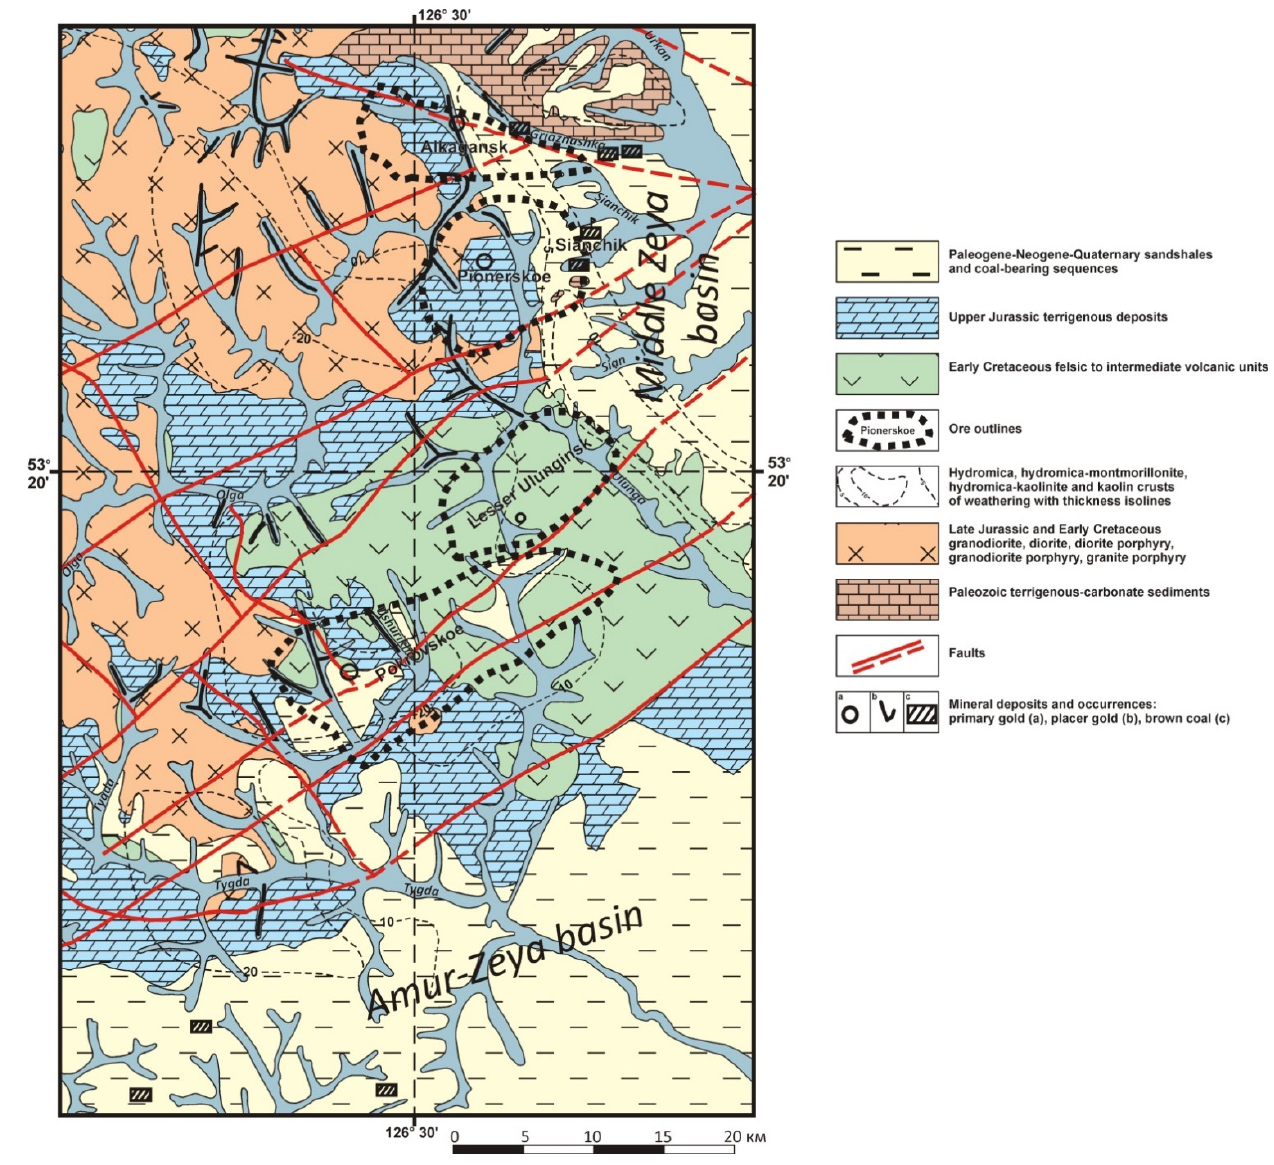
Figure 2. Zones of adjacent mineralized areas of the Tygda-Ulunginsky cluster and the Cenozoic basin [29], with additions by the authors. Table 2. Gold contents in weathering rocks of gold deposits and occurrences in the Tygda–Ulunginsky cluster of the Gonzhinsky gold district, modified from [28] and [30].